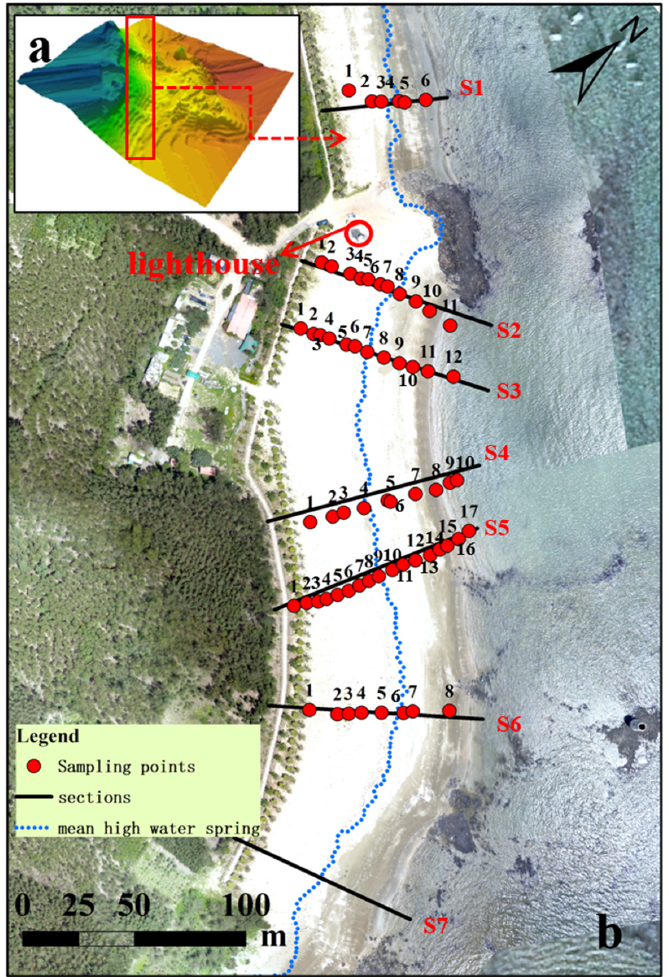
Figure 4. ( a ) Digital elevation model (DEM) of the beach in the Baimao tourist area in 2020; ( b ) graph layout for beach monitoring in the field site with the location of seven sections and sixty-four samples. The blue dashed line can also indicate the supratidal and intertidal zones.